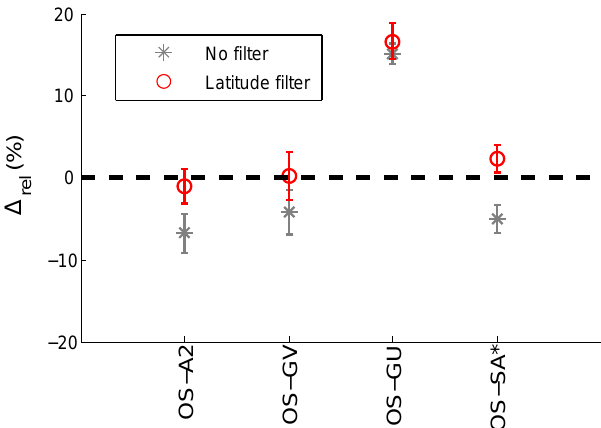
Fig. 15. Mean relative difference for spring-time OSIRIS minus ACE-FTS v2.2, GBS-vis, GBS-UV, and SAOZ NO 2 without (grey stars) and with (red circles) additional ± 1 ◦ latitude selection crite- ria. Errorbars indicate standard